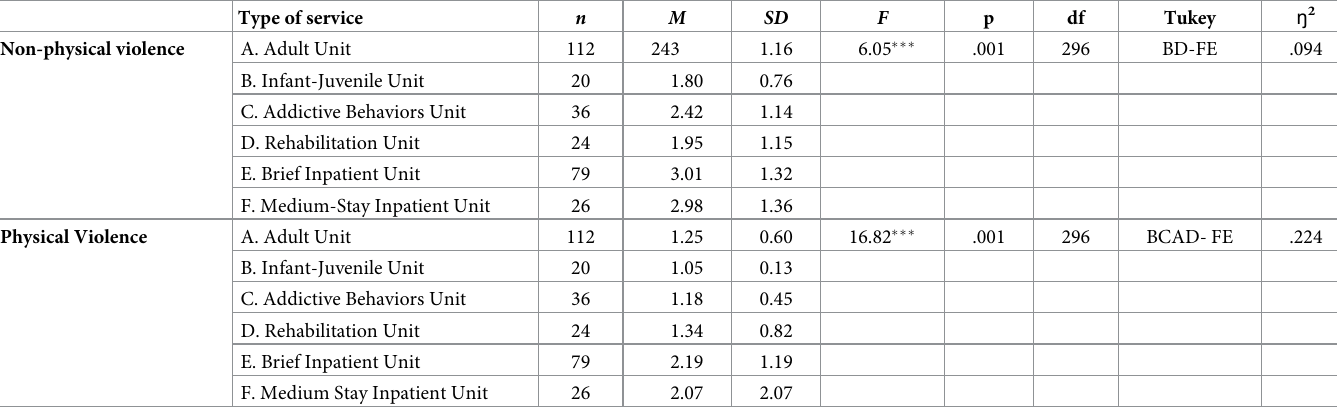
Table 6. Descriptive statistics and ANOVA of Non-physical and physical violence as a function of the type of service. Type of